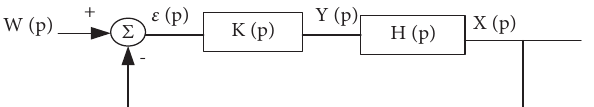
Figure 7: Block diagram of regulation giving the transfer